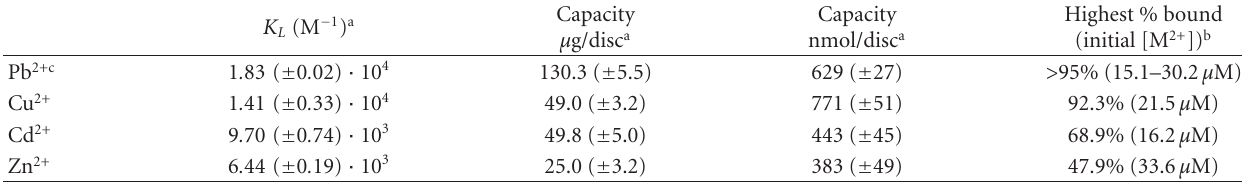
Table 3: Binding parameters of synthetic-eumelanin-coated discs with di ff erent metal